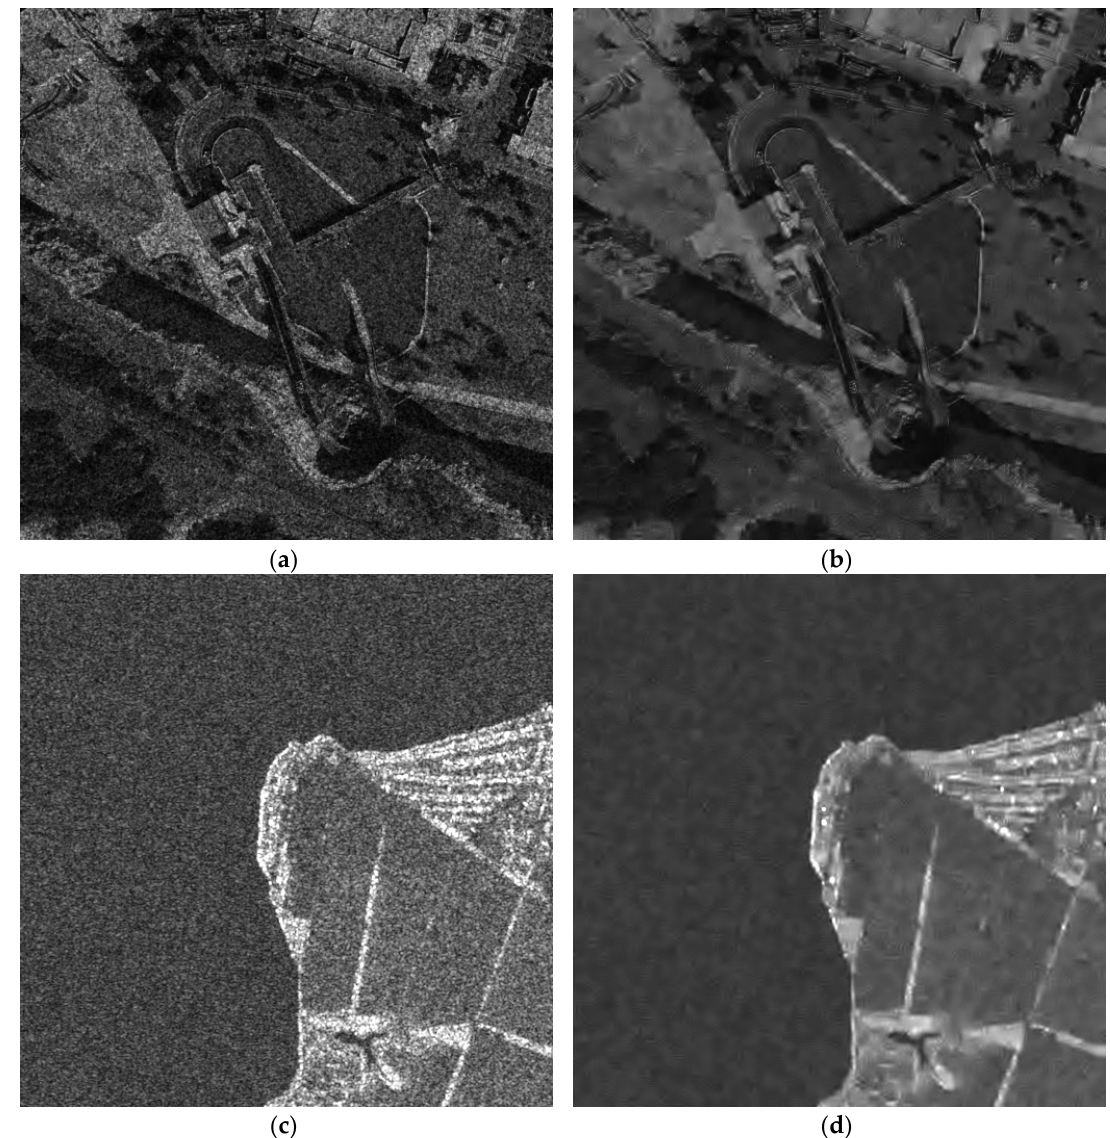
Figure 7. Noisy ( a, c ) and filtered ( b, d ) test ( a, b ) and real-life ( c, d ) images. Figure 7. Noisy ( a , c ) and filtered ( b , d ) test ( a , b ) and real-life ( c , d )